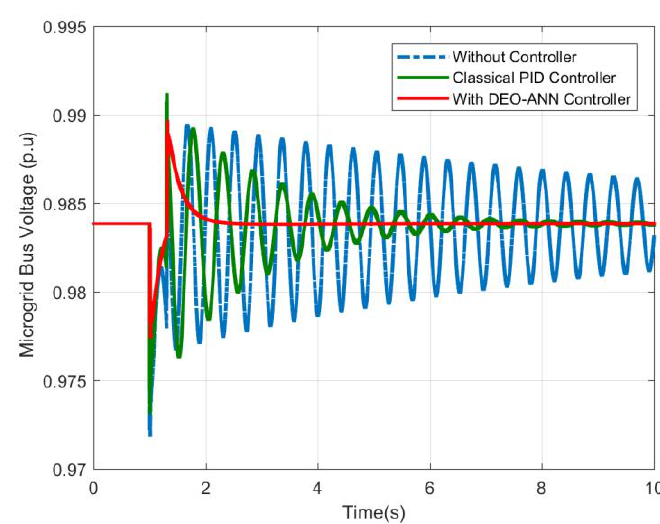
Figure 13. MG system voltage (in p.u).